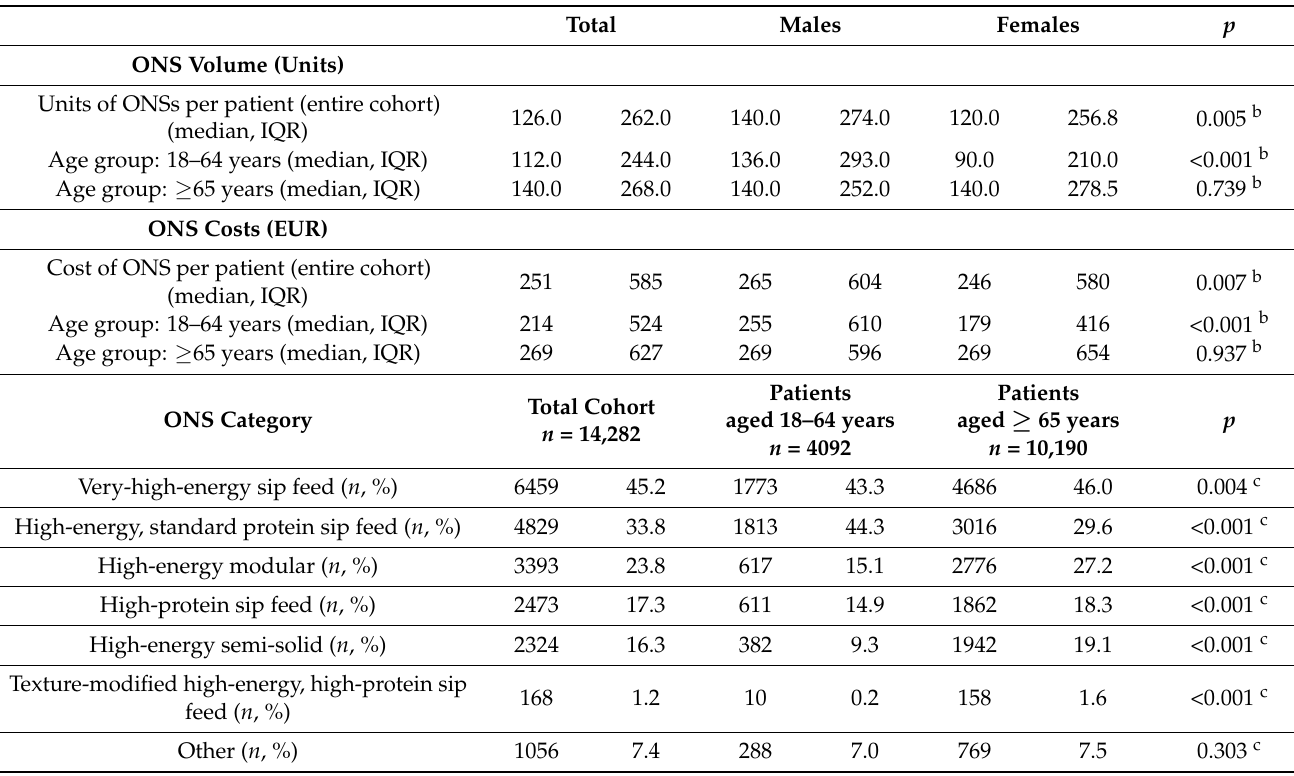
Table 2. Characteristics of oral nutritional supplement usage over a 12-month